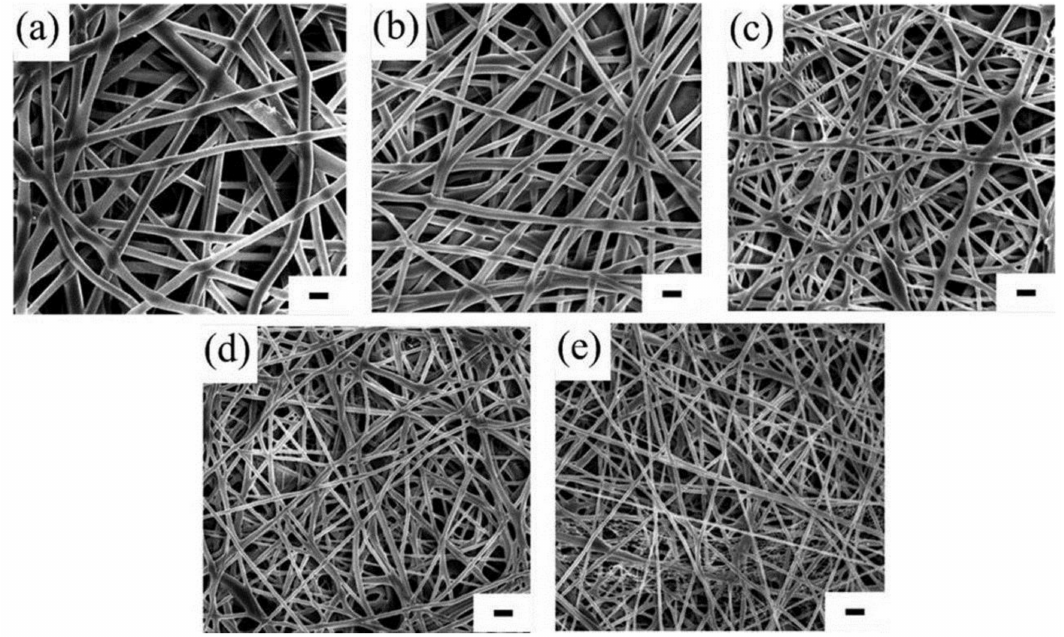
Figure 15. SEM images of soy protein isolate (SPI)/ polyamide 6 (PA6) nanofibrous membranes with different SPI/PA6 mass ratios: ( a ) 1:9; ( b ) 2:8; ( c ) 3:7; ( d ) 4:6; and ( e ) 5:5. Scale bar = 1 µ m [168]. Reproduced with permission from ref. [168]. Copyright John Wiley and Sons,